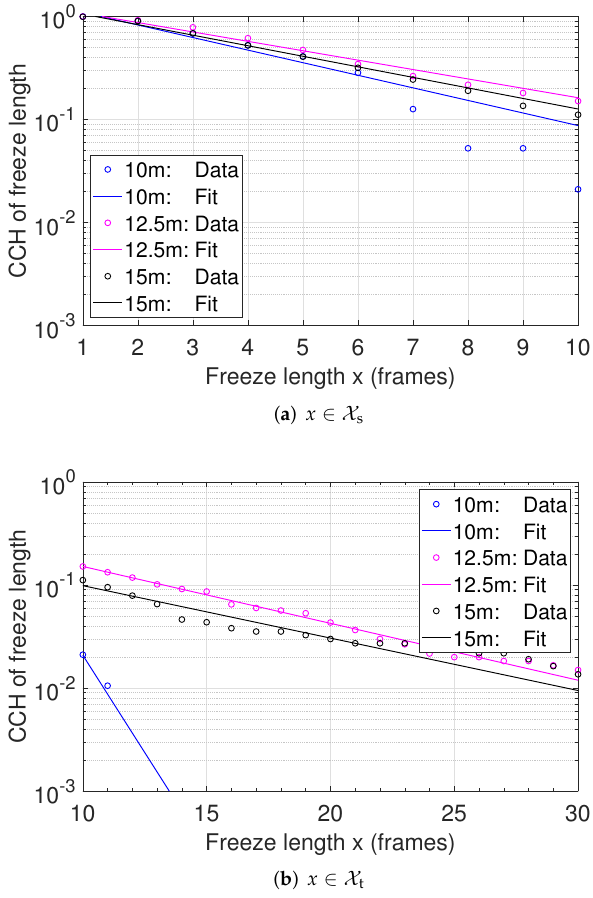
Figure 12. Fitting functions over all quadrants for different distances d : ( a ) Short freeze lengths x ∈ X s , ( b ) Long freeze lengths x ∈ X t